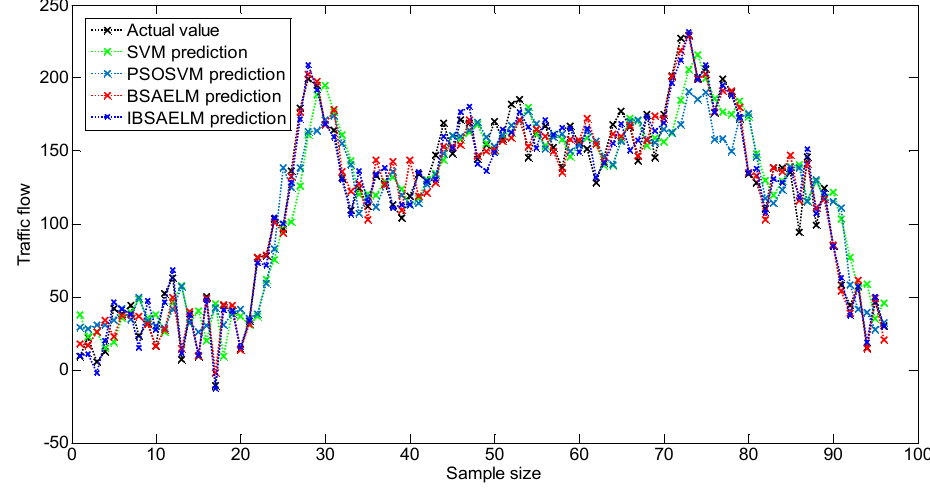
Figure 4. Forecast results of traffic flow sequence for one-day.